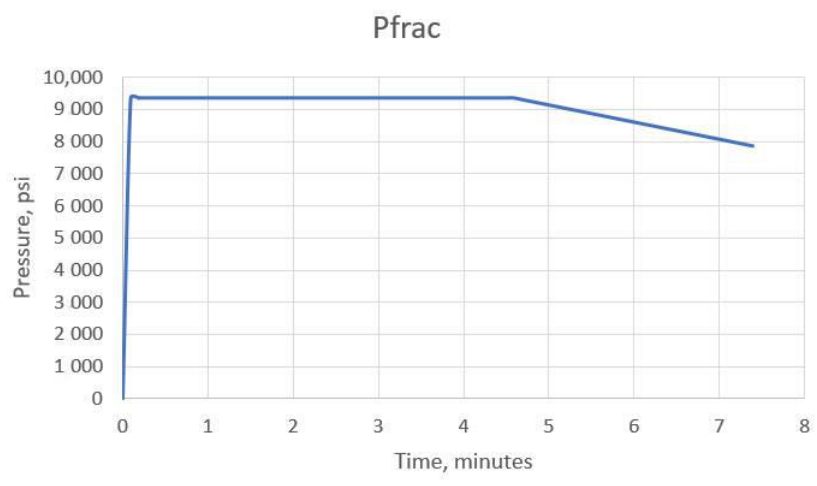
Figure 8. Fracture pressure vs. time with end of injection at 4.58 min.